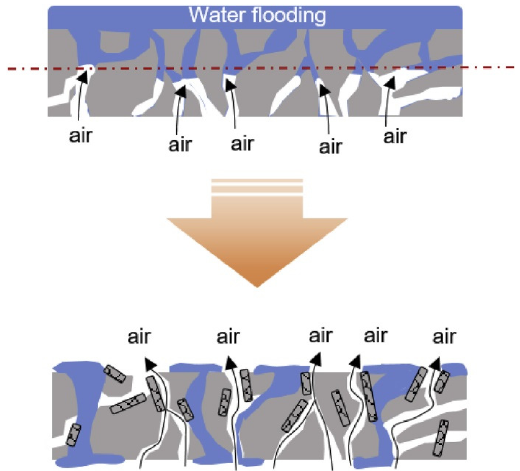
Figure 5. Improved water management due to graphitized carbon nanofibers incorporated in the cathode layer. Reprinted from [180], with permission from Elsevier.